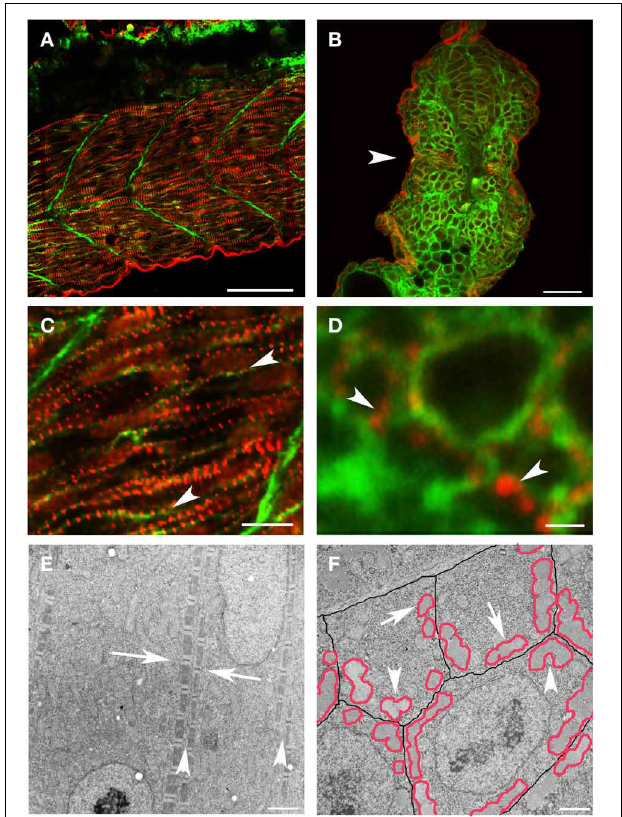
FIGURE 2 | New myofibril assembly occurs adjacent to the sarcolemma in skeletal muscle. (A–D) Zebrafish embryos at 24hpf were injected with lyn-GFP mRNA (which encodes for a GFP-fluorescent tagged protein that localizes to the cell membrane) and immunostained for α -actinin (red) and GFP (green) to mark the sarcomere and the sarcolemma respectively. Note that α -actinin dots ( C,D : arrowheads) appear in a striated pattern immediately adjacent to the sarcolemma in both longitudinal optical (A,C) and transverse (B,D) sections. (E) Ultrastructural analysis reveals that there is a consistent relationship between new myofibrils that are forming on either side of the sarcolemma ( E : arrowheads) and that there is a slight offset in the alignment of Z bands ( E : arrows) across myocytes at this stage of development. In transverse sections (F) , note that the myofibrils (outlined in red) form in close proximity to the sarcolemma (outlined in black) with preferential clustering in regions where three cells intersect (arrowheads). There are examples of myofibrils (arrows) that are not paired with a myofibril in an adjoining cell, suggesting that the organization of myofibrils across myocytes may not be direct and therefore may require patterning of the extracellular matrix to transmit architectural